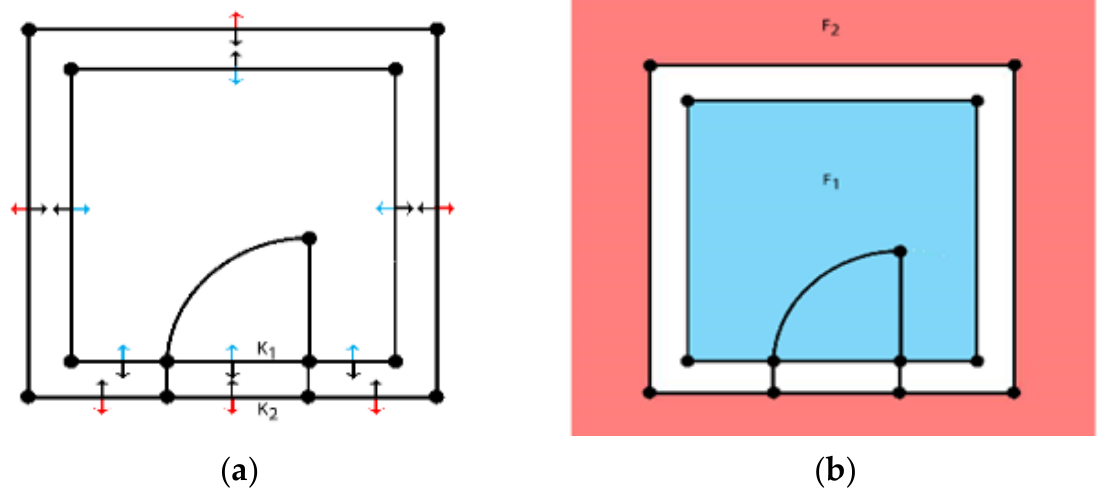
Figure 12. ( a ) Detection process of the room polygon. ( b ) Blue area (F1) defines a room whereas the red area (F2) the outside of the apartment.